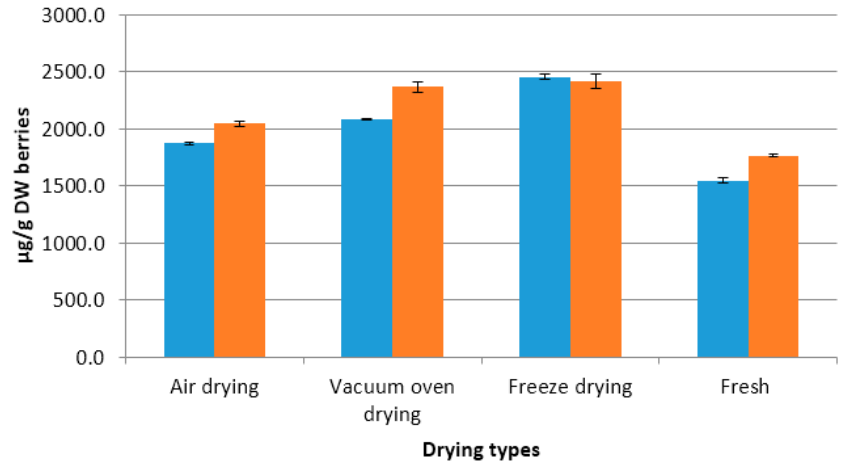
Figure 5. Levels of steroidal alkaloids in potato berries dried using different drying methods (Error bars represent standard deviation, n = 6).